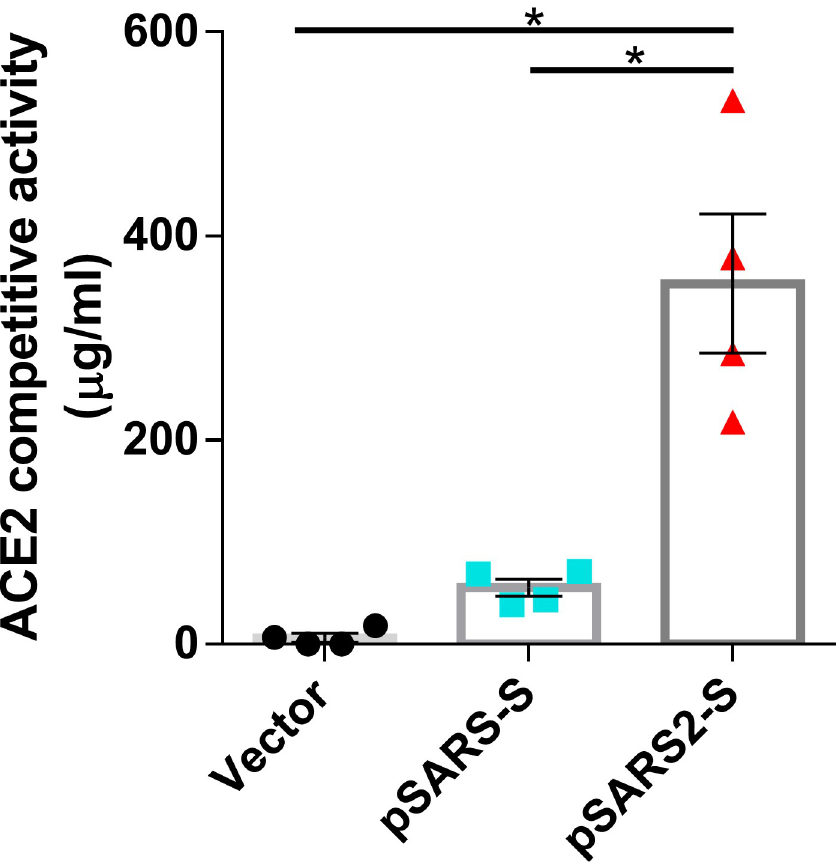
Fig 3. Competitive activity of immunized mouse sera against the RBD/ACE2 interaction. BALB/c mice (n = 4 per group) were intramuscularly immunized twice at a 3-week interval with 100 μ g of vector, pSARS-S or pSARS2-S, followed by electroporation. Serum samples were collected at week 8 after the first immunization. Serum antibodies that compete with ACE2 for RBD binding were evaluated by competitive SARS-CoV-2 serology assay. The competitive activity of the mouse sera is expressed as the equivalent level of anti-RBD (SARS-CoV-2 spike protein) antibody (reference antibody). Antibody titers are presented as the mean ± SEM. � p < 0.05 by the Mann-Whitney test.